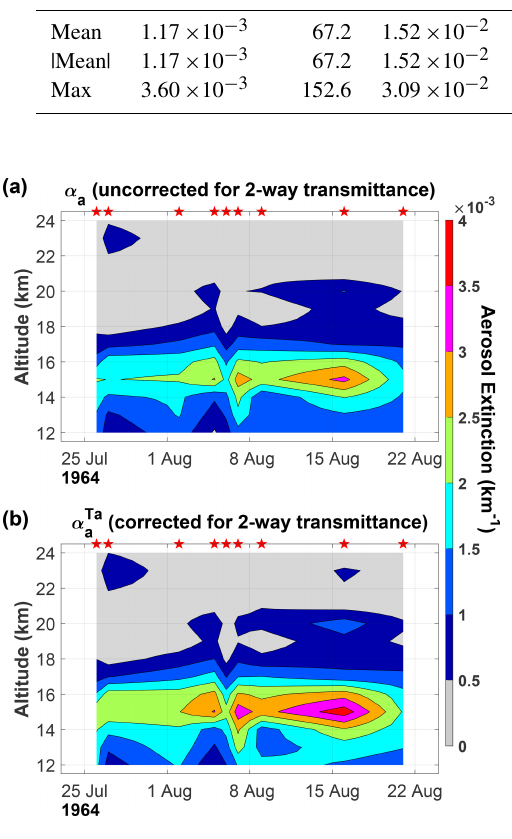
Figure 6. Contour plots of the vertical profiles of 532nm aerosol extinction, α a (532 ,z ) ∗ , at Fairbanks, showing values uncorrected and corrected for two-way transmittance, α T a a (532 ,z ). The red stars indicate the dates on which the measurements were conducted.